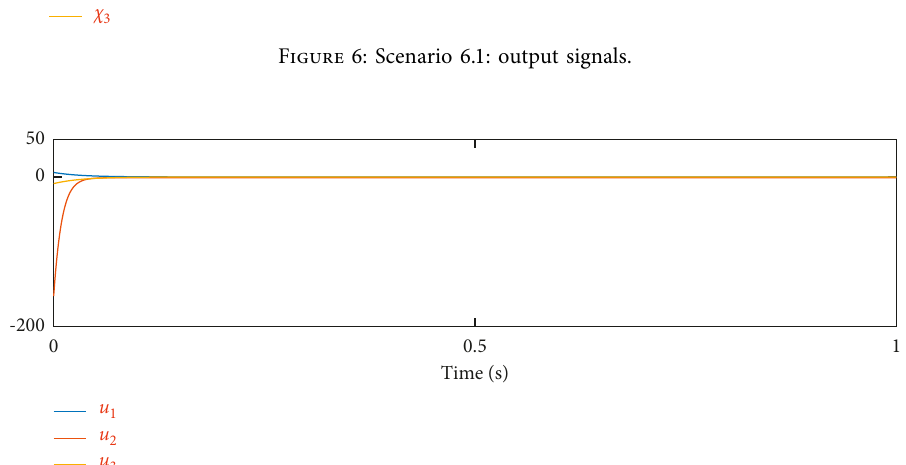
Figure 7: Scenario 6.1: control